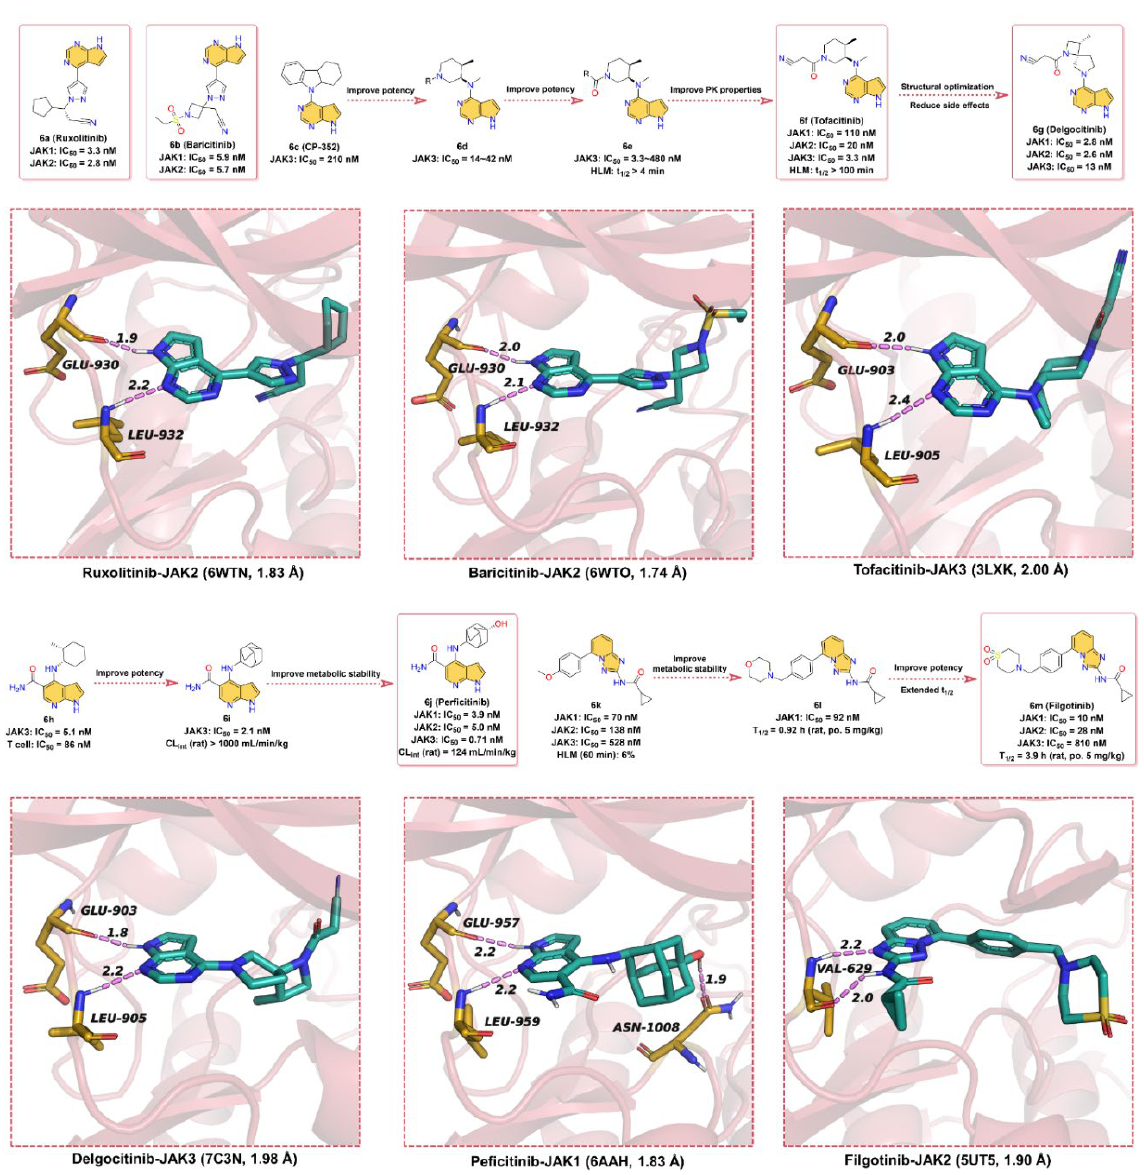
Figure 6. Key medicinal chemistry optimization of JAKs inhibitors along with the binding models with JAKs.